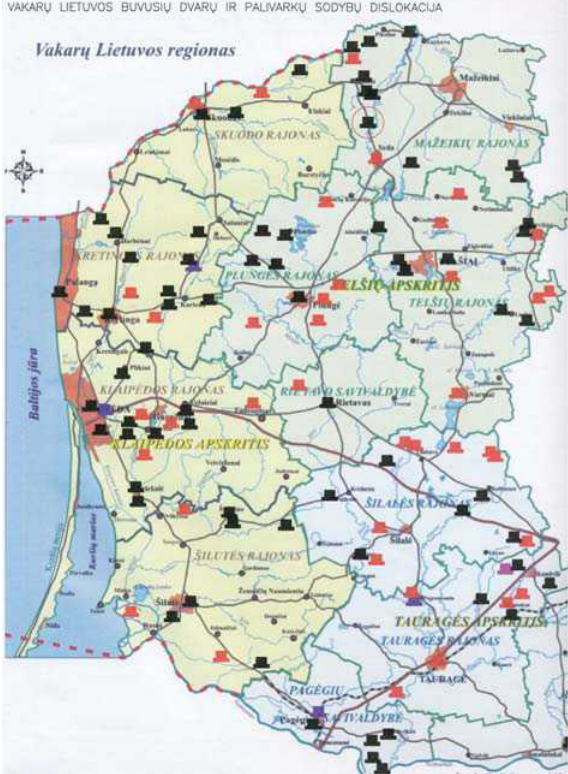
buvusios dvarų sodybos, įregistruotos kultūros vertybių apsaugos departamento registre buvusios dvarų sodybos, išbrauktos iš kultūros vertybių apskaitos kaip visiškai sunykusios arba nebeišlikusios buvusios palivarkų sodybos, įregistruoros kultūros vertybių apsaugos departamento registre buvusios palivarkų sodybos, išbrauktos iš kultūros vertybių apskaitos kaip visiškai sunykusios arba